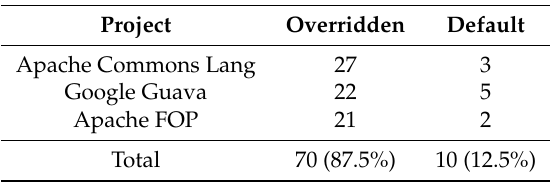
Table 2. The numbers of objects with overridden/default string representations in randomly-sampled documentation